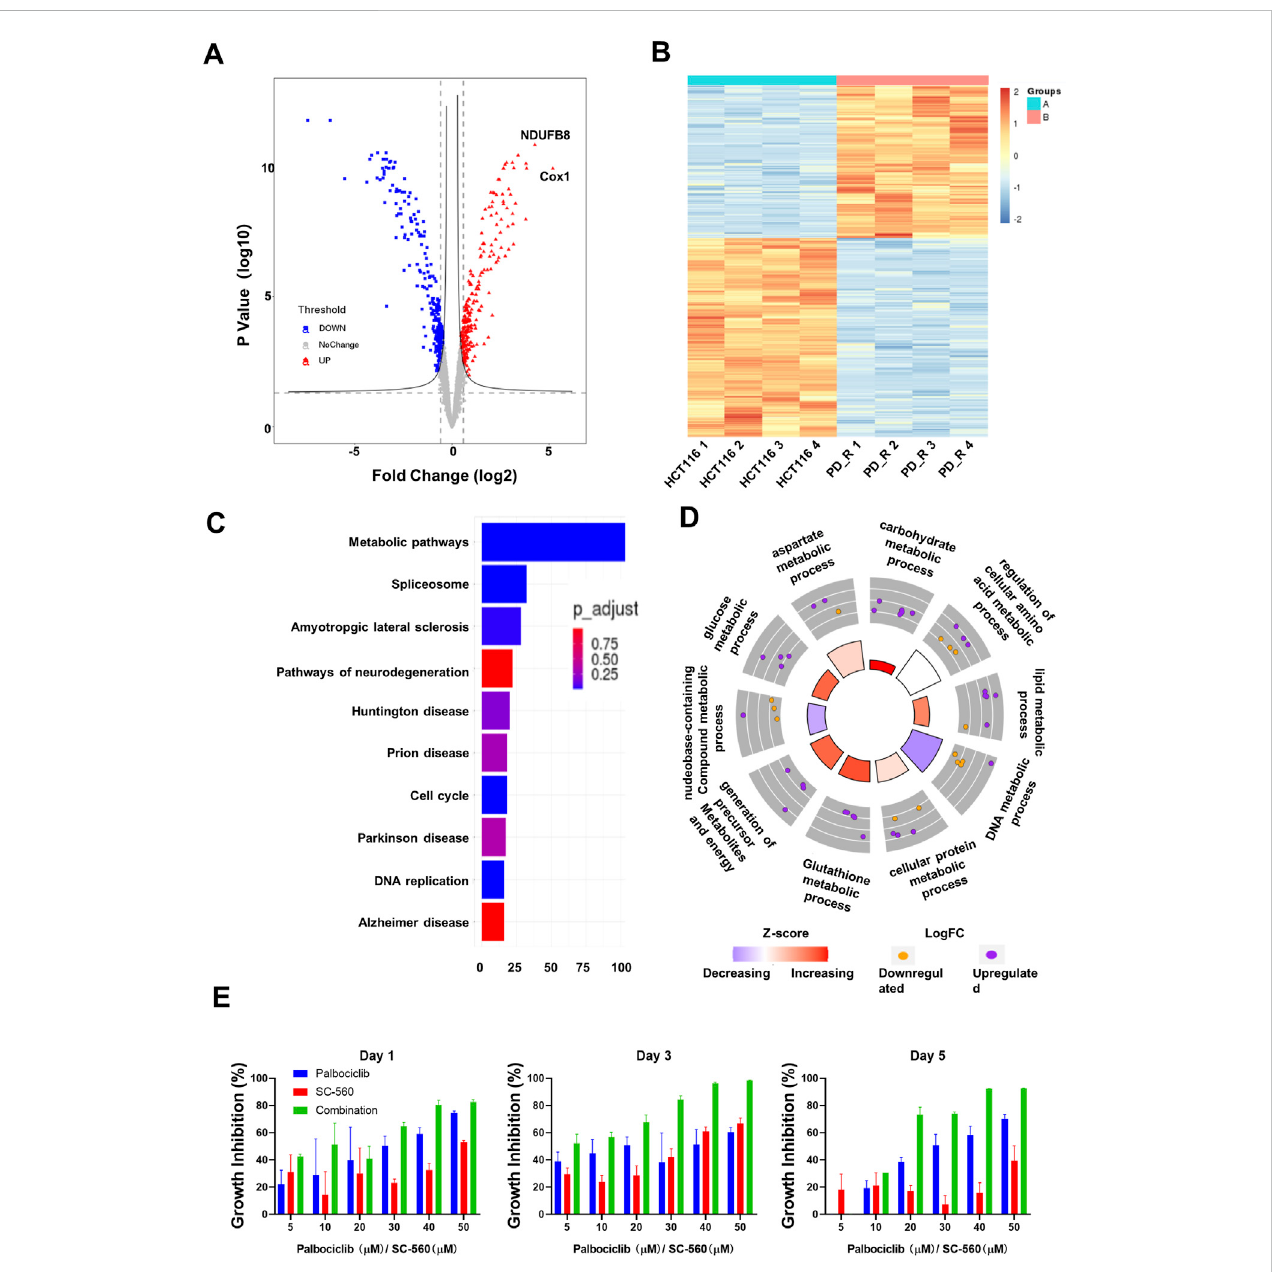
FIGURE 2 Quantitative proteomic analysis of HCT116 and HCT116 PD_R cells. (A) Volcano plot of proteomic data constructed using fold changes (HCT116 PD_R/ HCT116) and adjusted p values. Red dots: signi fi cantly upregulated proteins. Blue dots: signi fi cantly downregulated proteins. Gray dots: proteins with no signi fi cant changes. (B) Heat map generated from the normalized intensity of the 526 DEPs across two study groups. (C) Top ten enriched KEGG pathways of the DEPs. (D) GO Circle plot of the top ten metabolic-related enriched biological processes of the DEPs between HCT116 PD_R versus HCT116. The upregulated (purple dots) and downregulated (blue dots) proteins in each process are distributed in the outer circle of the plot. The inner-circle displays the Z-score, calculated as the number of upregulated proteins minus the number of downregulated proteins divided by the square root of the total count. The larger Z-score represents more upregulated proteins enriched in the process. The color of the Z-score represents the increasing or decreasing expression of the process. (E) Growth inhibition rate of the combination treatment of SC-560 with palbociclib in HCT116 PD_R cells. Three-time points were designed as drugtreatmentfor1day,3days,and5daysrespectively.FivedosesofSC-560(10,20,30,40,and50 μ M)werecombinedwith fi vedosesofpalbociclib(10,20, 30,40, and 50 μ M). Data were represented as mean ±